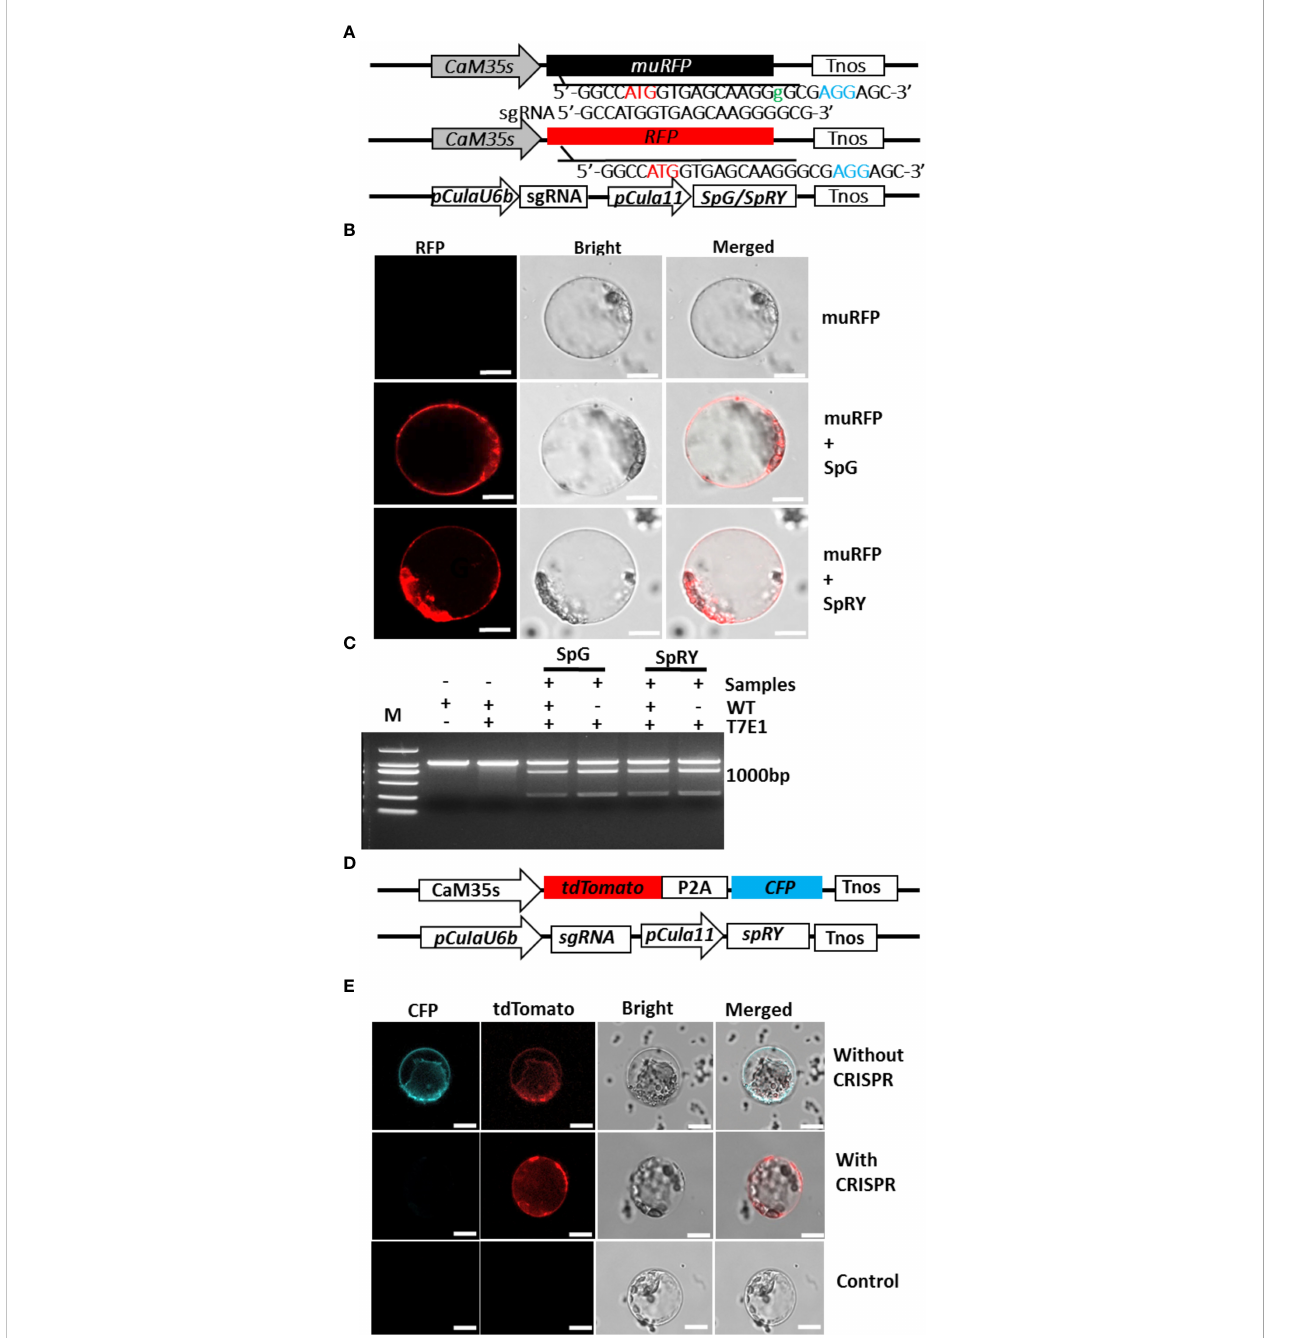
FIGURE 3 Application of Cula11 promoter in the CRISPR/Cas mediated genome editing in Chinese fi r protoplasts. (A) Strategies for verifying CRISPR/Cas constructs in Chinese fi r protoplasts. Constructs expressing non-functional muRFP (Top) and optimized CRISPR elements (Bottom) were co- transformed, and muRFP will be corrected to RFP once the CRISPR elements work (Middle). (B) Representative Chinese fi r protoplasts expressing muRFP (Top), and co-transfected with SpG and SpRY expressing constructs that reproducibly emitting fl uorescence signals (Middle and Bottom),Scale bar: 10 m m. (C) Detecting of target mutations by T7 endonuclease ( T7E1 ) assay. (D) Alternative strategy for verifying CRISPR / Cas constructs in Chinese fi r protoplasts. The tdTomato and CFP simultaneously expressed under CaM35S promoters (Top), and CRISPR plasmid which sgRNA was driven by pCulaU6b and SpRY driven by pCula11 . (E) Detection of gene mutation in Chinese fi r protoplasts. Representative protoplasts simultaneously expressing CFP and tdTomato without CRISPR plasmid (Top), and CFP signal disappeared when optimized CRISPR elements work (Middle), protoplasts that give no fl uorescence were used as control (Bottom). Scale bar: 10 m